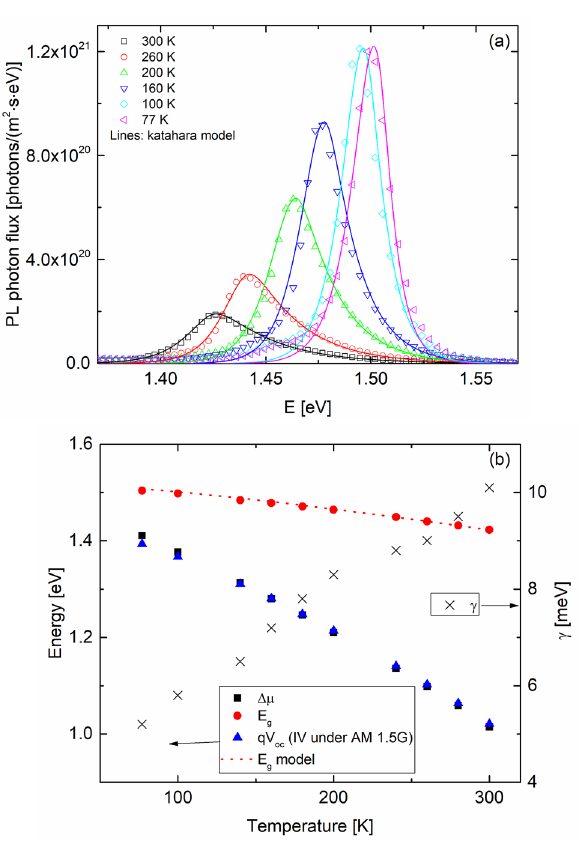
Figure 4. ( a ) A sampling of the absolute photon flux spectra of the BB transition at several temperature s , extracted from a large field of view (3.5 mm). Solid lines are Katahara model calculations . ( b ) The temperature dependence of the fit parameters, plus the qV oc measurements under AM 1.5